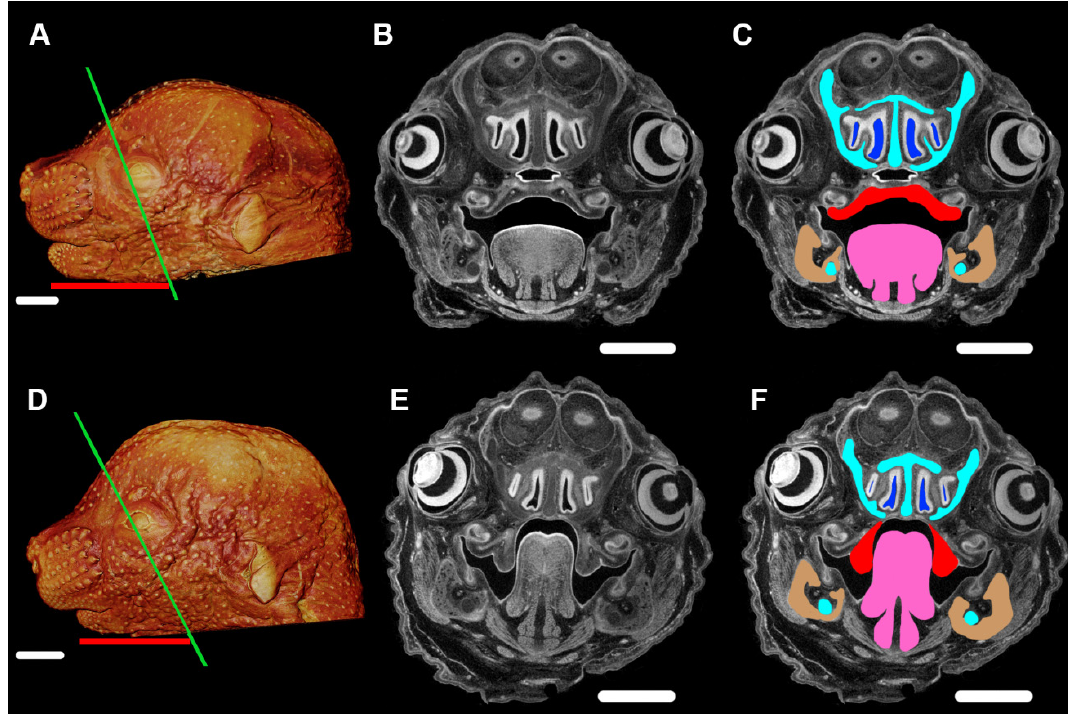
Figure 3. Pierre Robin phenotype of mandible, tongue, and cleft palate in the Prdm16 cGT / cGT embryos visualized by PTA-enhanced µ CT. ( A ) Three-dimensional volume rendering of a PTA-enhanced µ CT image of an E15.5 Prdm16 +/+ mouse showing craniofacial morphology of a typically developing embryo. ( B ) Slice image of typical morphology, plane of section indicated by the green line in ( A , C ). Same image as ( B ), highlighting critical tissues of the PR-CP phenotype, namely, the nasal capsule and Meckel’s cartilage (aqua), nasal airways (blue), palatal shelves (red), tongue (pink), and mandible (tan). ( D ) 3D volume rendering of a PTA-enhanced Prdm16 cGT / cGT mouse showing the PR-CP phenotype. ( E ) Slice image of PR-CP morphology, plane of section indicated by the green line in ( D , F ). Same image as ( E ), highlighting critical tissues of the PR-CP phenotype, namely, the nasal capsule and Meckel’s cartilage (aqua), nasal airways (blue), palatal shelves (red), tongue (pink), and mandible (tan). ( A , D ) Length of mandible shown by red bar. Scale bars in ( A , D ) are 1 mm. Scale bars in ( B , C , E , F ) are 500 µ m. Imaging processing as described for Figure 2.